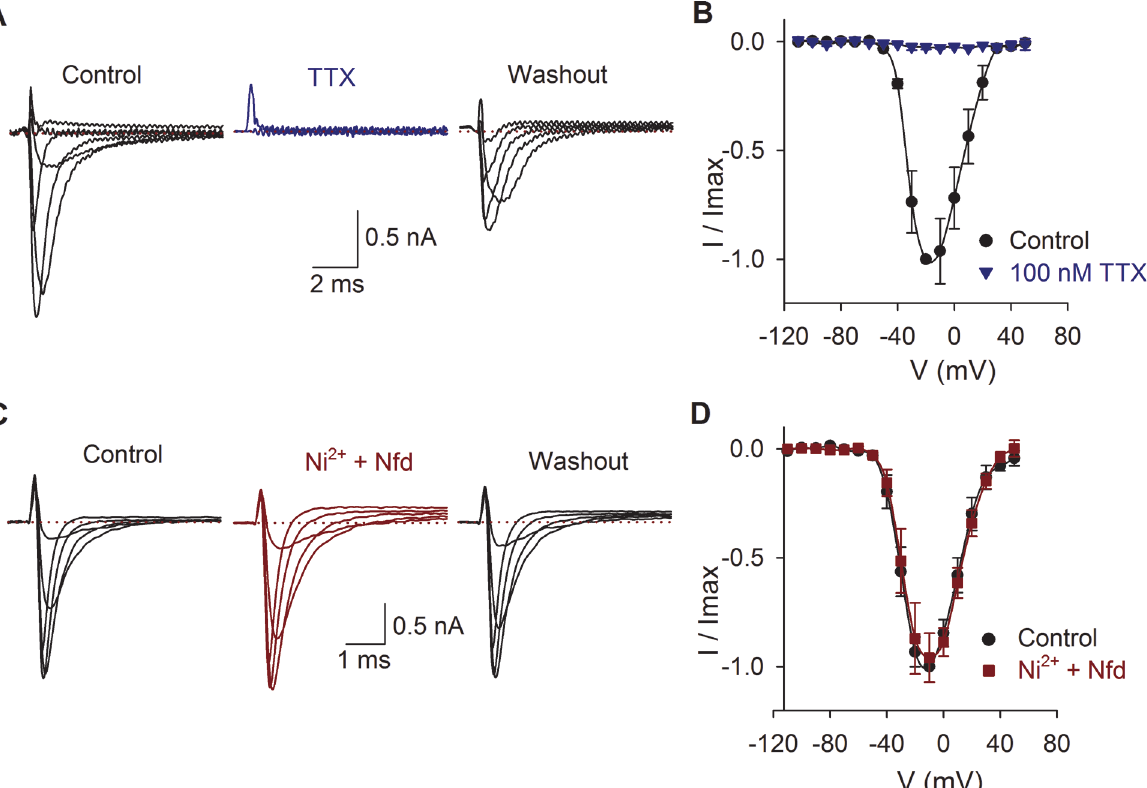
Fig 1. Effects of TTX, nickel and nifedipine on the I Na . A) I Na produced by voltage pulses from − 110 mV to 50 mV in control conditions, during 100 nM TTX perfusion and 2 min after washout. In this and the following figures, only representative traces are shown. B) Current-voltage relationship in control conditions (black) and with TTX perfusion (blue). C) Current recording in control conditions and after coapplication of 10 μ M nifedipine (Nfd) and 100 μ M nickel. D) Current-voltage relationship in control conditions (black) and with Ni 2+ plus nifedipine perfusion (red). In all traces, the dotted line indicates zero current.